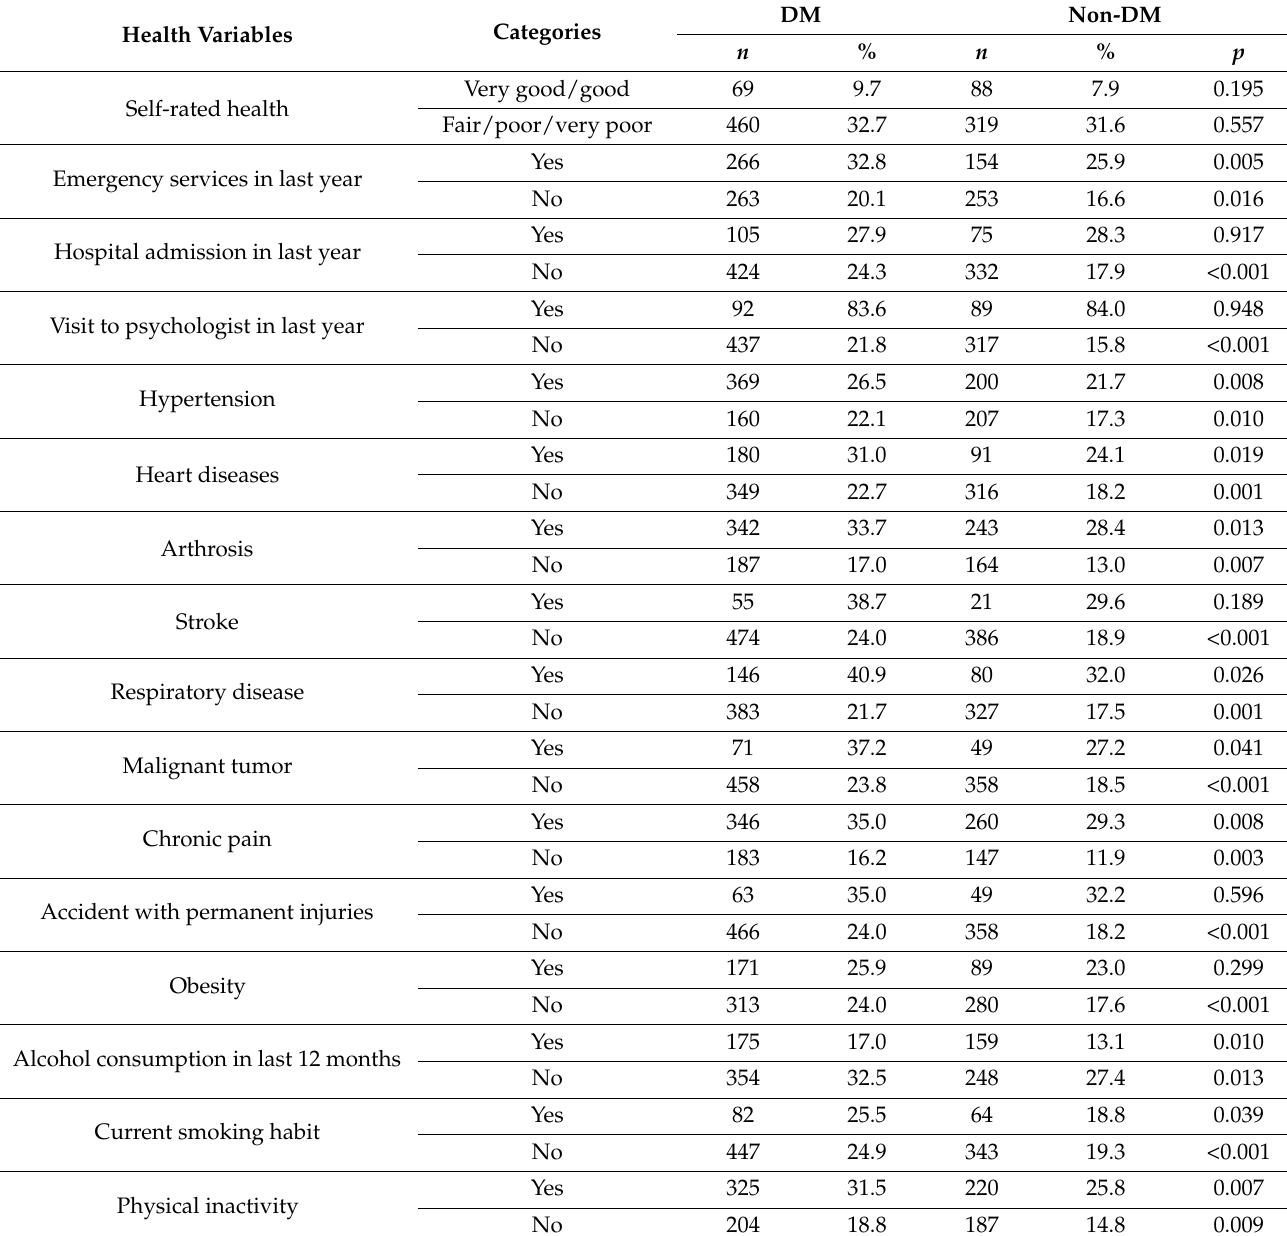
Table 1. Prevalence of mental disorder according to health variables among subjects with DM and matched non-DM controls. (Spanish National Health Interview Survey, 2017).